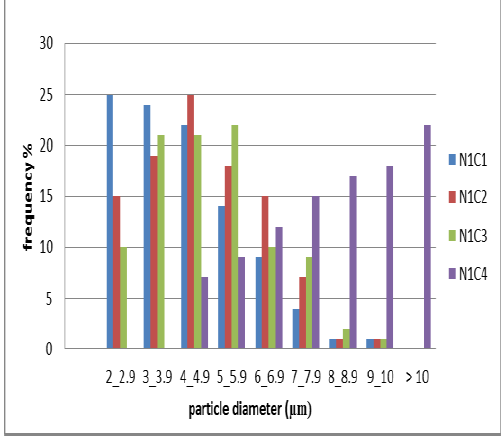
Figure(2): Histogram showing the effect of increasing chitosan concentration on frequency distribution analysis of nystatin- loaded microparticles formulas Determination entrapment efficiency